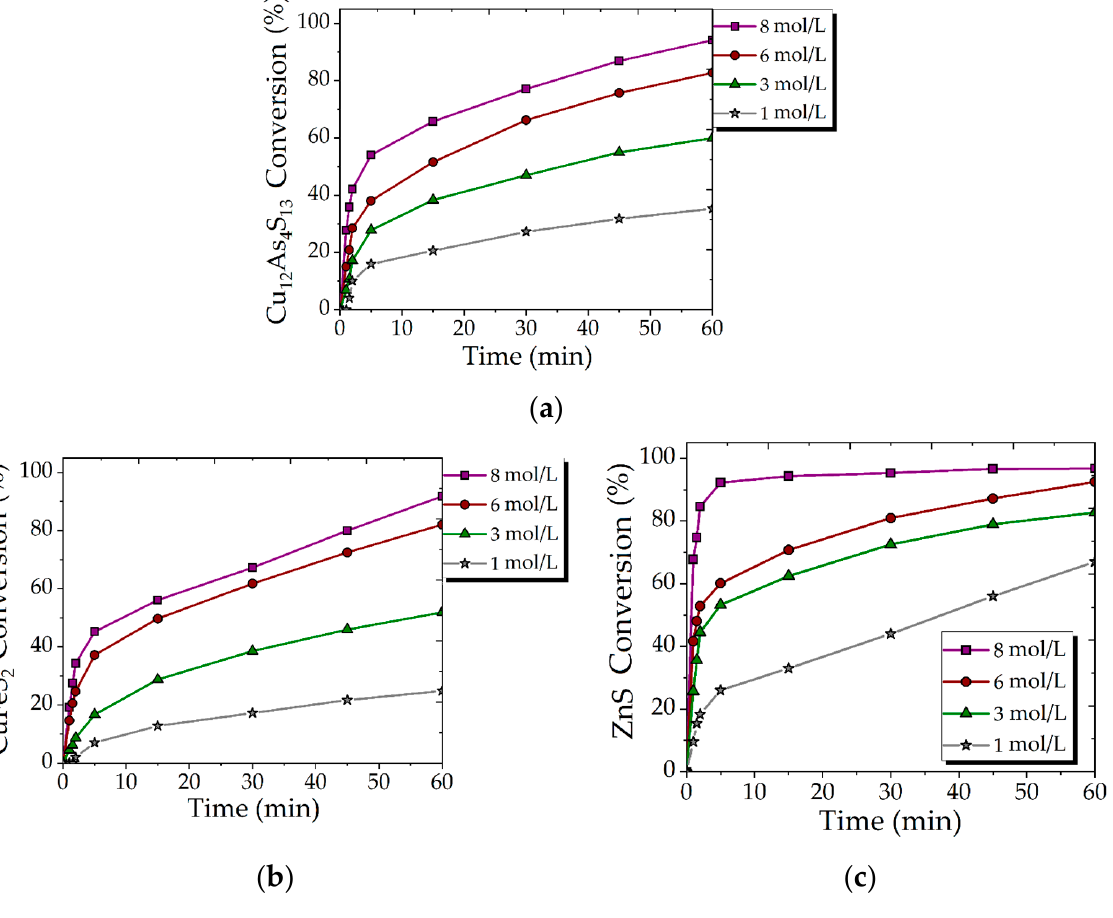
Figure 3. Effect of HNO 3 concentration on the conversion of Cu 12 As 4 S 13 ( a ), CuFeS 2 ( b ) and ZnS ( c ) (300 rpm; 353 K; 0.018 mol/L Fe (III); FeS 2 /synt. conc = 1/1). The significant effect of HNO 3 concentration on the reaction rate and conversion extent may also indicate that the reactions are controlled by diffusion through the product layer, where the increasing HNO 3 concentration in the initial solution leads to acceleration